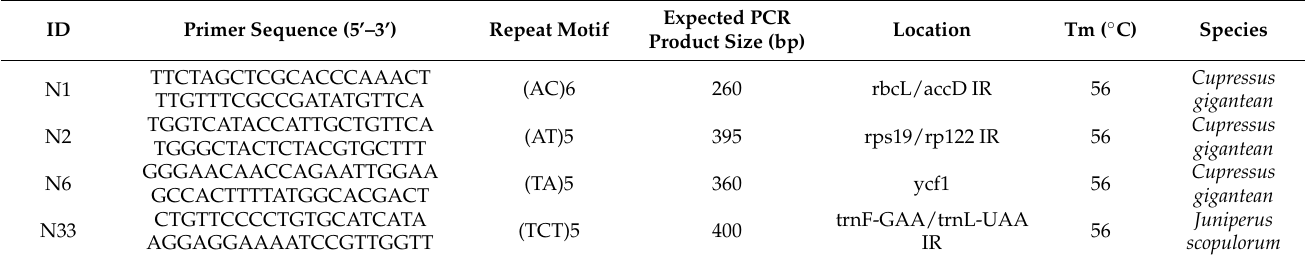
Table 2. Characteristics of four cpSSR loci for PCR amplification in P. orientalis